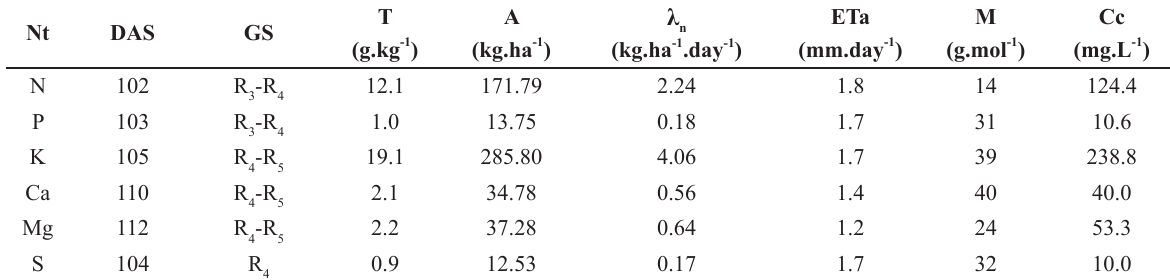
, mg.l -1 ) of each macronutrient (nt) in crude sap (xylem) of the maize crop (hybrid DKb 390 critical concentration (c c pro 2 ) at the day (DAS, days) of maximum absorption rate (λn, kg.ha -1 .day -1 ) corresponding to the growth stage (Gs); as function of the molecular weight (M, g.mol -1 ), whole plant content (t, g.kg -1 ), nutrient absorption (a, kg.ha -1 ) and